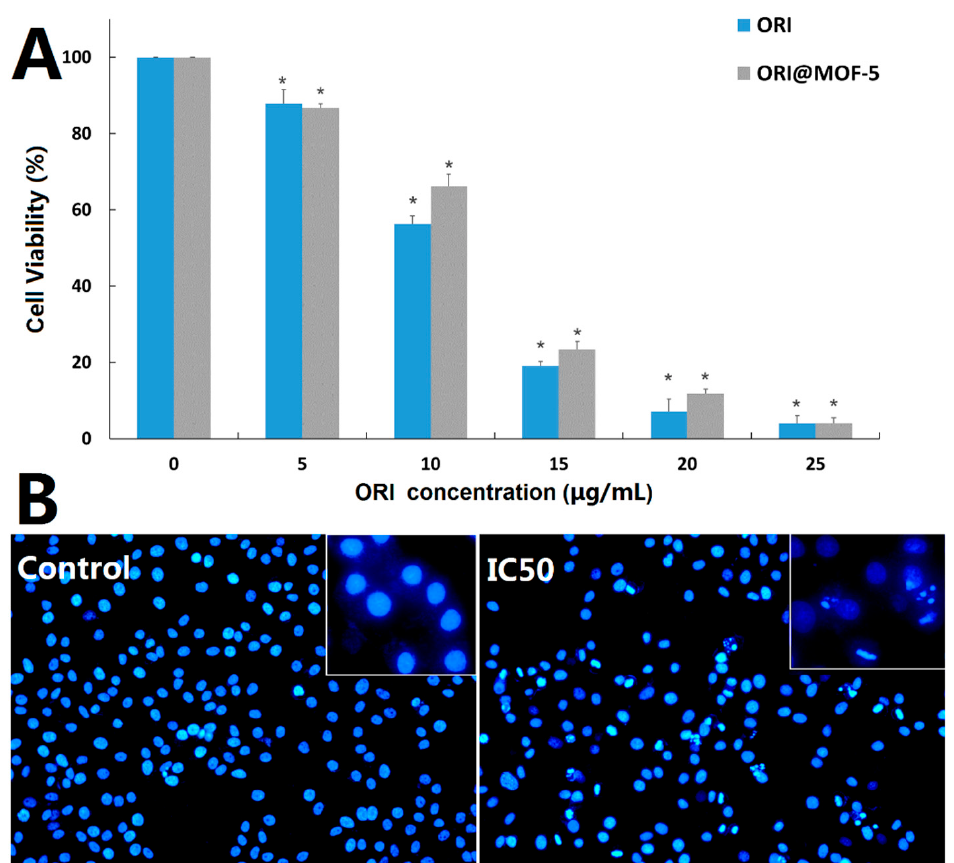
Figure 10. ( A ) In vitro cell viabilities of HepG2 cells after being incubated for 24 h with various concentrations of ORI and ORI@MOF-5; ( B ) Fluorescence microscopic images of HepG2 cells stained with DAPI after 24-h treatment with ORI@MOF-5 (at IC50 value).